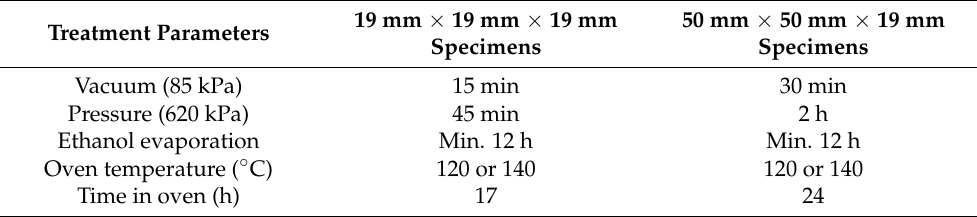
Table 1. Parameters used for impregnation and thermal treatment depending on samples size. Treatment